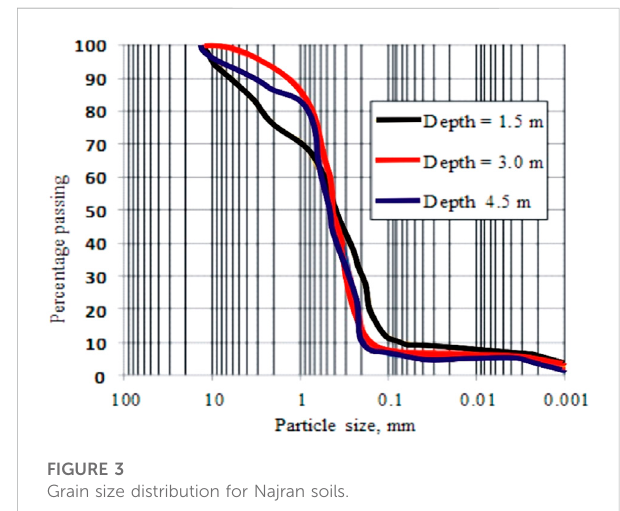
FIGURE 3 Grain size distribution for Najran soils.